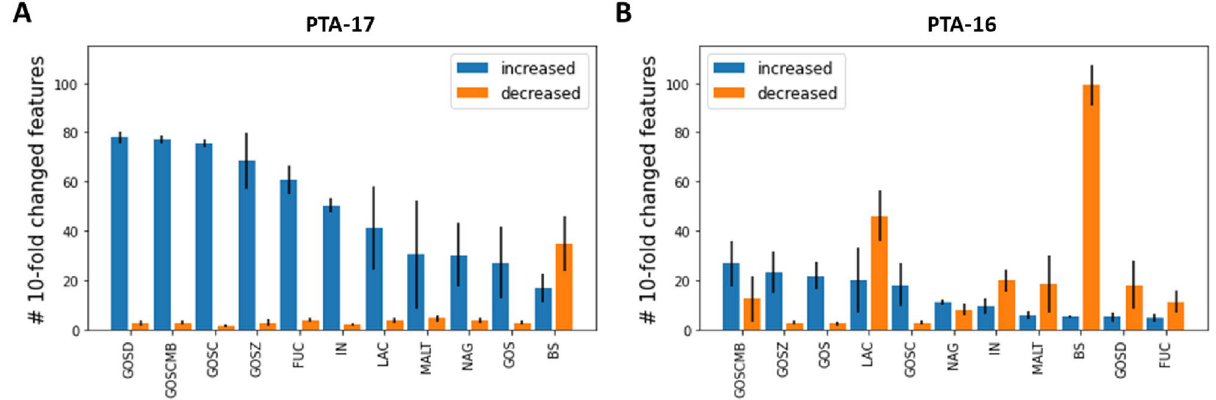
Figure 6. Features showing at least tenfold difference in abundance with different media additives compared to a control condition. ( A ) The number of features with higher than tenfold increase or decrease in abundance in media supplemented with different prebiotics and/or additives compared to a glucose media control for strain PTA-17. Error bars represent the standard error of the mean across replicates (n = 3). ( B ) Like ( A ), but for strain PTA-16. In both panels, prebiotics and/or additives are sorted according to the number of metabolites with increased